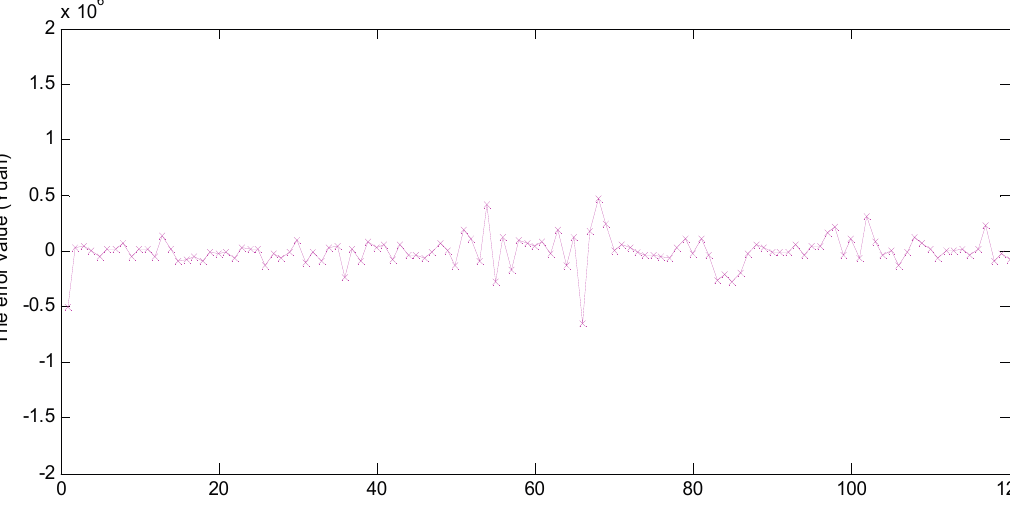
Figure 5. Prediction results based on APAPSO-LMS algorithm.